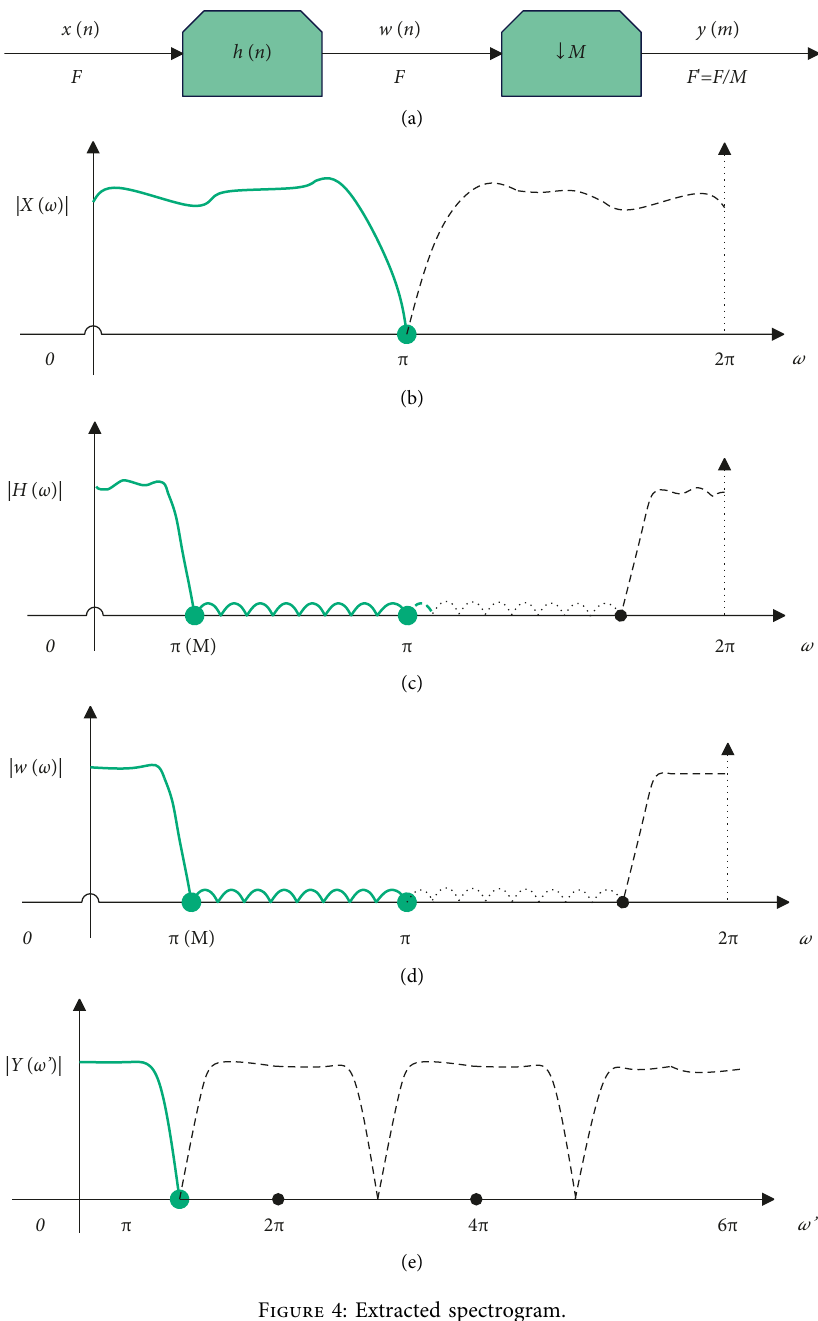
Figure 4: Extracted